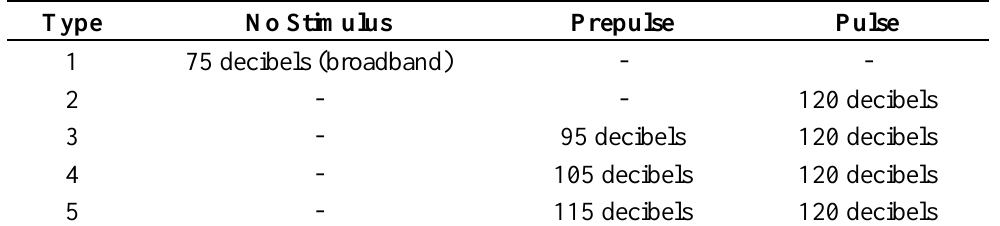
Table 1. Protocol for Delivery of Auditory Stimuli in the Acoustic Startle